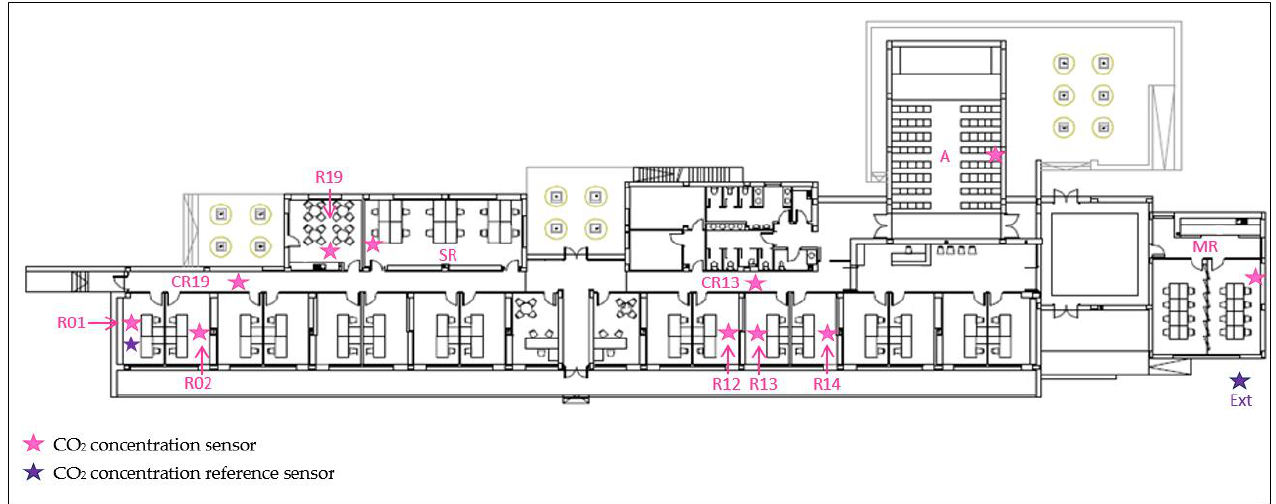
Figure 1. Overview of the building plant indicating the spaces where the CO 2 sensors are installed. Sensor nomenclature is showed.